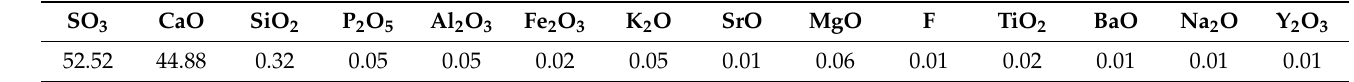
Table 6. Main chemical composition analysis of gypsum concentrates (mass fraction, %).